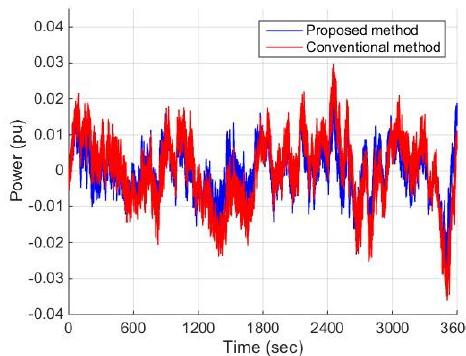
Figure 14. Power transmission between two adjacent MGs. ( a ) power transmission between MG 1 and MG 2 ; ( b ) power transmission between MG 2 and MG 3 .